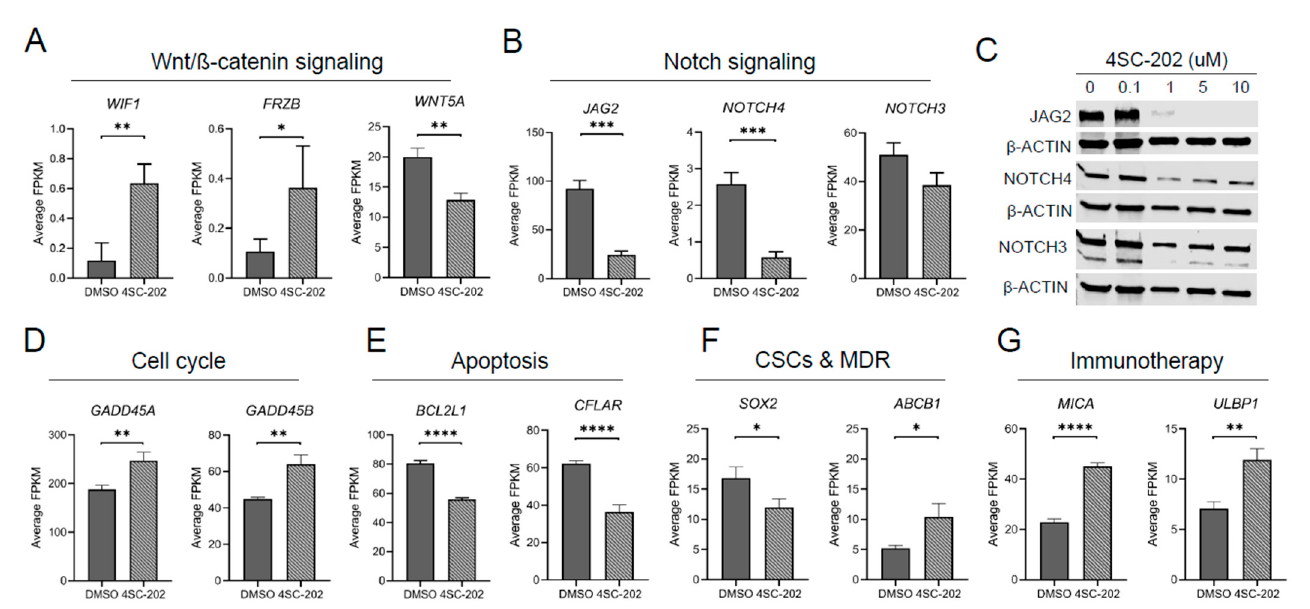
Figure 8. Candidate genes regulated by 4SC-202 in human SJSA-1 OS cells. Selected differentially expressed genes in ( A ) the Wnt/ß-catenin signaling pathway and ( B ) the Notch signaling pathway. ( C ) Representative Western blot analysis of JAG2, NOTCH4, NOTCH3, and β -ACTIN in OS cells treated with or without 4SC-202. Selected differentially expressed genes in ( D ) cell cycle, ( E ) apoptosis, ( F ) cancer stem cells (CSCs) and multidrug resistance (MDR), and ( G ) immunotherapy. Average FPKM values from RNA-seq analysis were used. * p < 0.05, ** p < 0.01, *** p < 0.001, **** p < 0.0001 . Data are presented as mean (SD) of triplicate samples treated with or without 4SC-202.